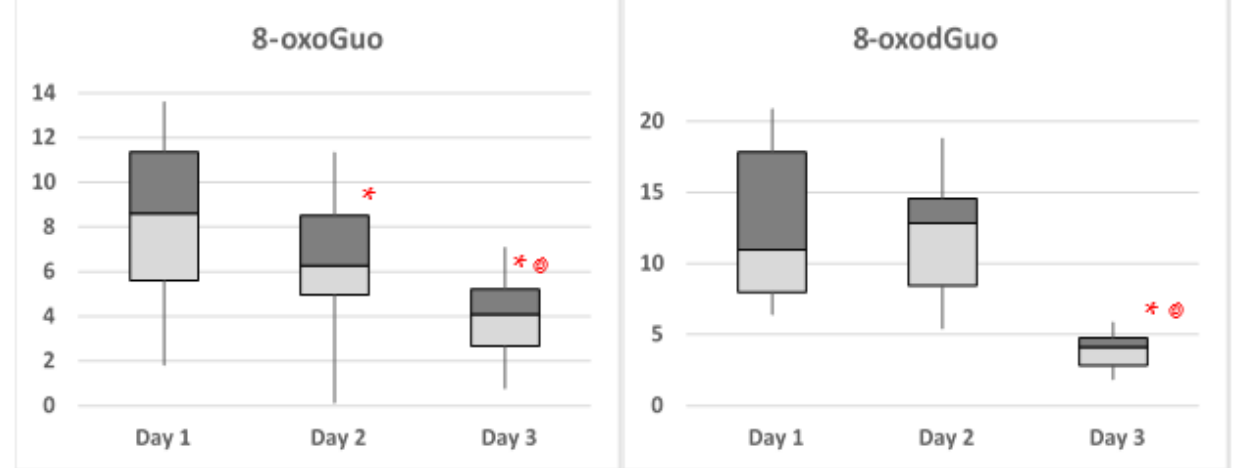
Figure 1. The box and whisker plots of the pooled biomarker values found in the three days of diving for 8-oxoGuo and 8-oxodGuo. A red asterisk indicates that the values are significantly lower than in day1 ( p < 0.01), and a red spiral indicates that the values are statistically significantly lower than in day 2 ( p < 0.01).